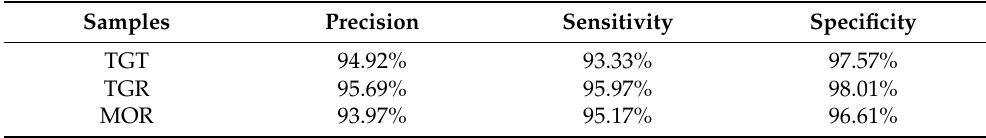
Table 3. Precision, Sensitivity and Specificity achieved in cross-validation by the final model contain- ing 6